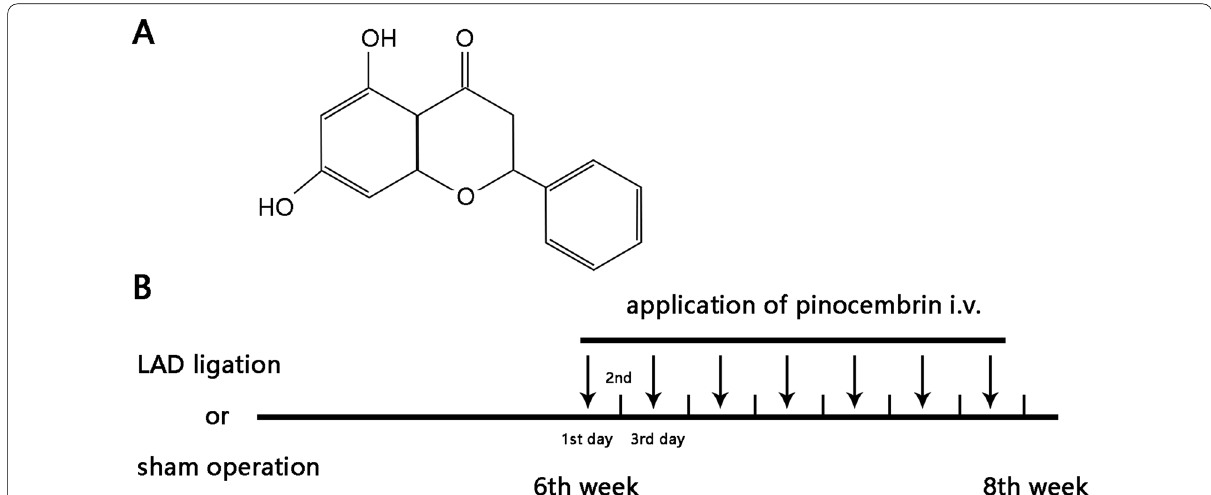
Fig. 1 The chemical structure of pinocembrin and the animal experimental protocol. A The chemical structure of pinocembrin was illustrated; B the animal experimental protocol where an arrow meant one time of administration of